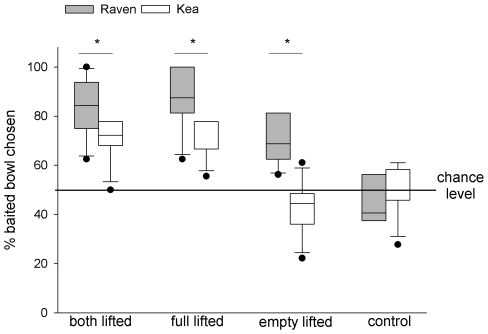
Percentage of trials in which the baited bowl was chosen in Experiment 2.Box plots show median and upper and lower quartile. Whiskers indicate 10%- and 90% - confidence interval. Between-species differences are indicated by asterisks (post-hoc Holm-Sidak test).